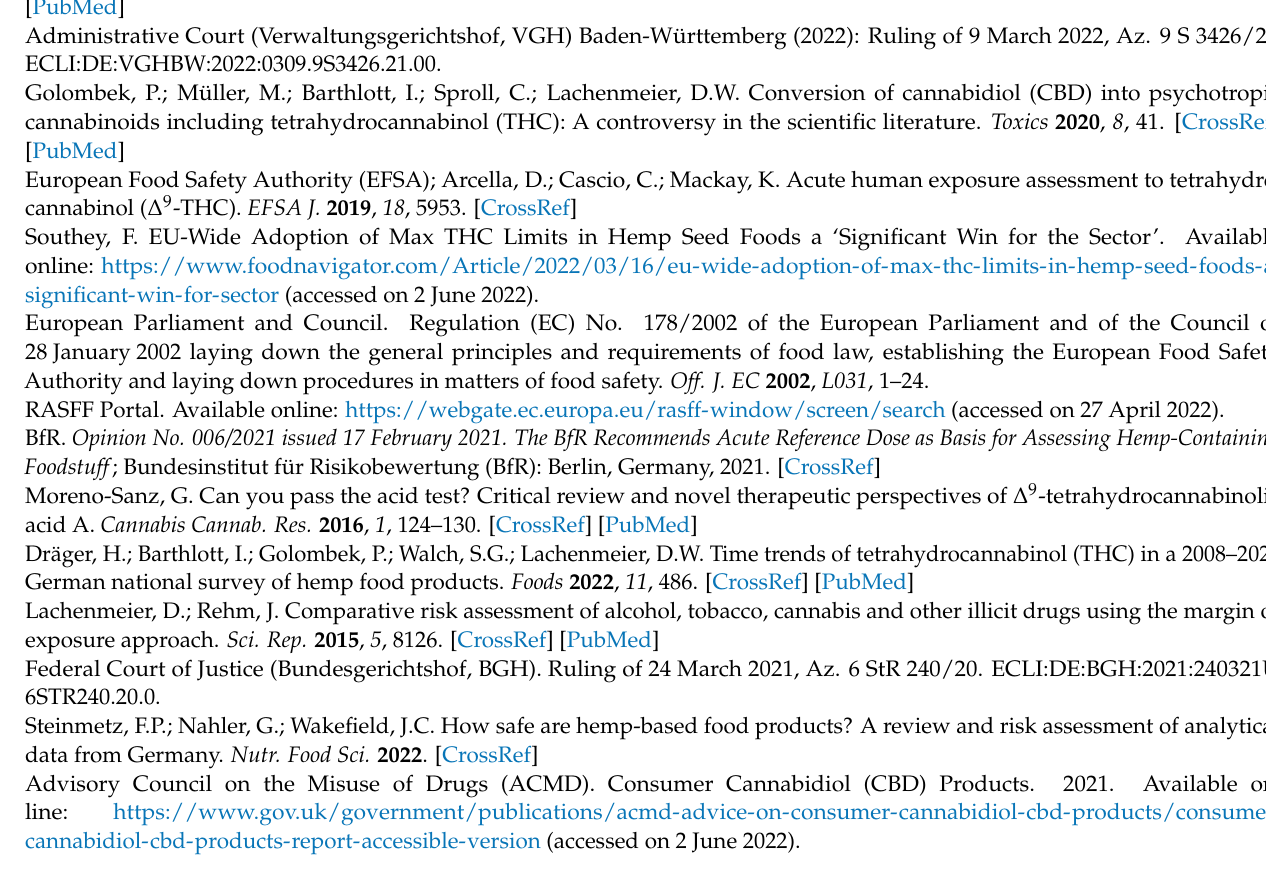
Table S3: Calculations of THC of all CBD oils and supplements from the RASFF portal that have been classified as undecided risk; Table S4: Summary for all samples; Table S5: Distribution of ∆ 9 -tetrahydrocannabinol levels in food supplements (data for Figure